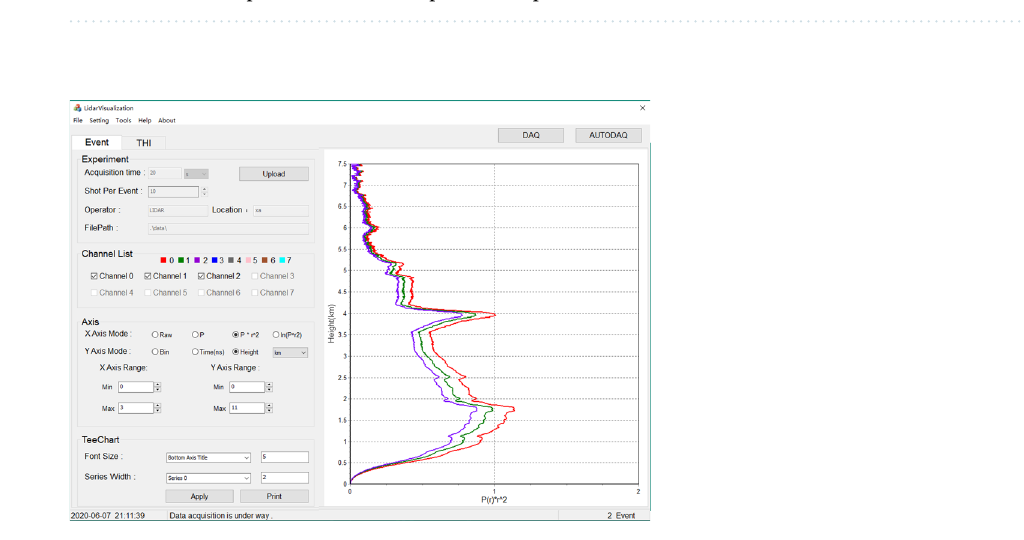
Figure 10. The interface of the software system.